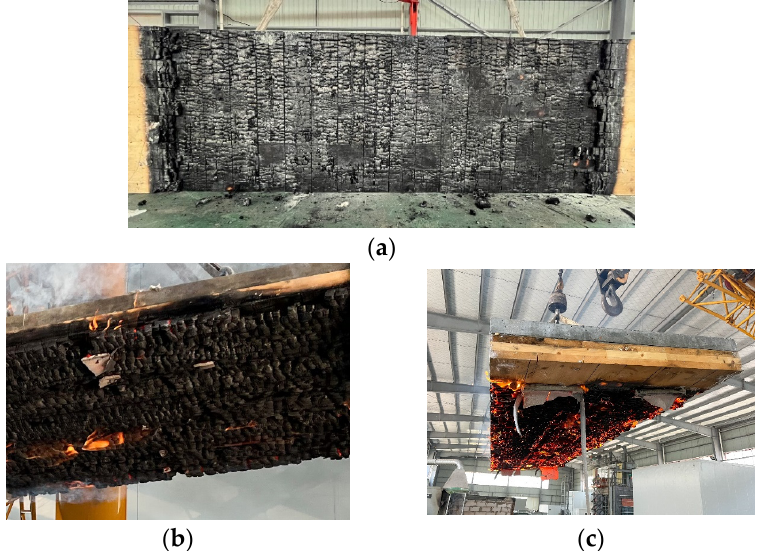
Figure 7. ( a ) Appearance of TCC1 after extinguishing; ( b ) TCG2 being lifted out; and ( c ) TCG3 being